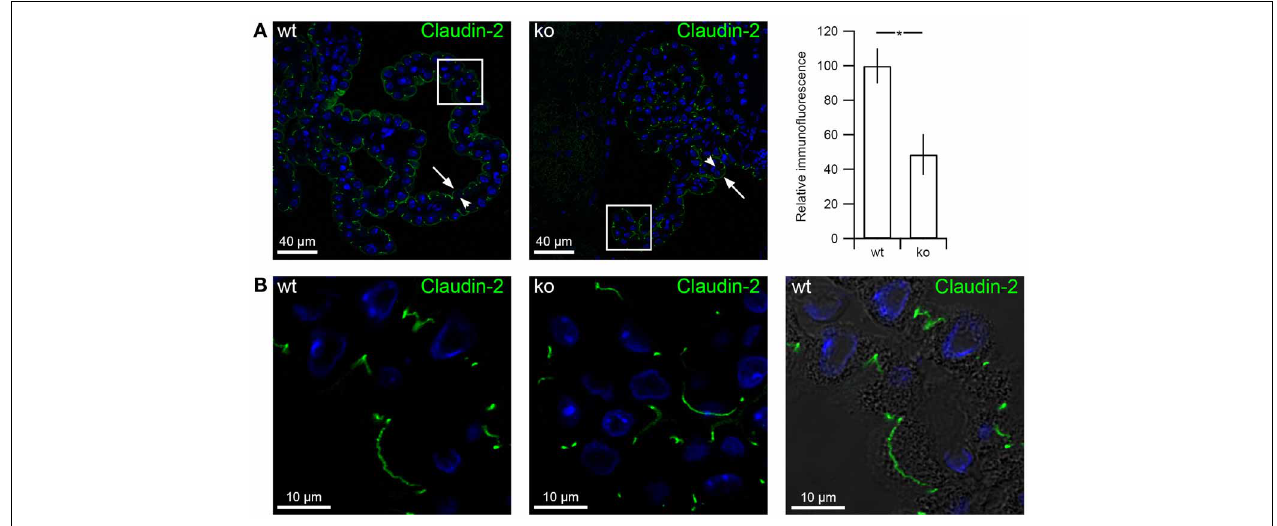
FIGURE 10 | Claudin-2 expression decreases in CPE from slc4a10 ko mice. (A) Immunohistochemical detection of claudin-2 in slc4a10 wt and ko CPE, as indicated. Bar graph on the right show the semi-quantitation of the immunofluorescence in slc4a10 wt and ko mouse CPE (wt: n = 5, ko: n = 3).